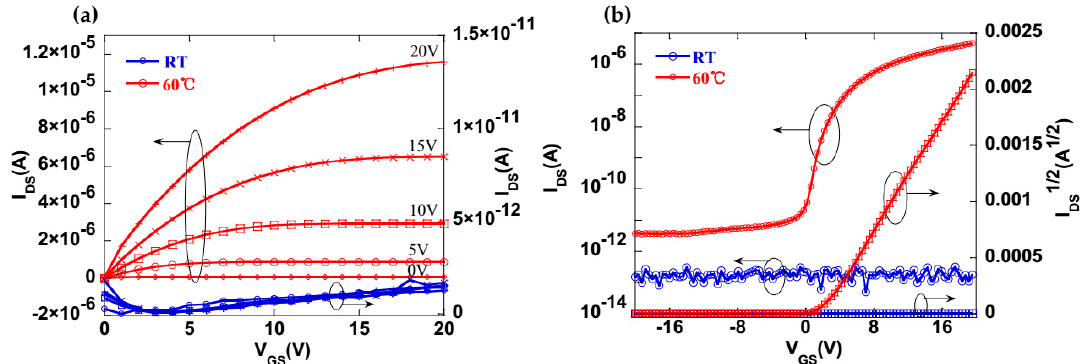
Figure 3. Output characteristic curves (I DS –V DS ) ( a ) and transfer characteristic curves (I DS –V GS ) ( b ) of manufactured a-IGZO TFTs with inkjet-printed Ag S/D electrodes as a function of substrate temperatures. V GS is varied from 20 to − 20 V with V DS = 10.1 V.